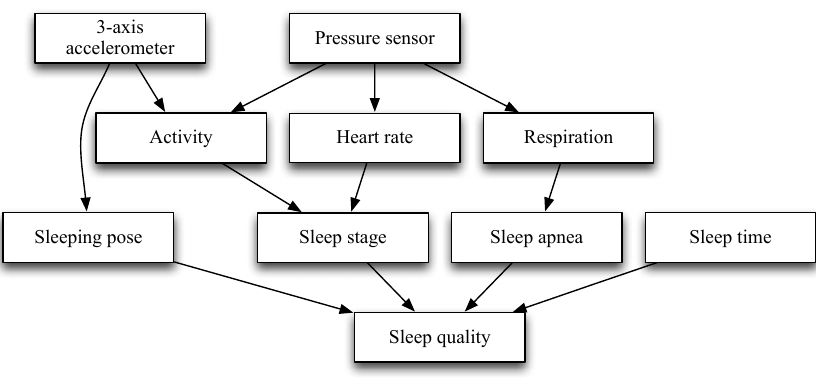
Figure 1. Process flow for sleep quality monitoring.